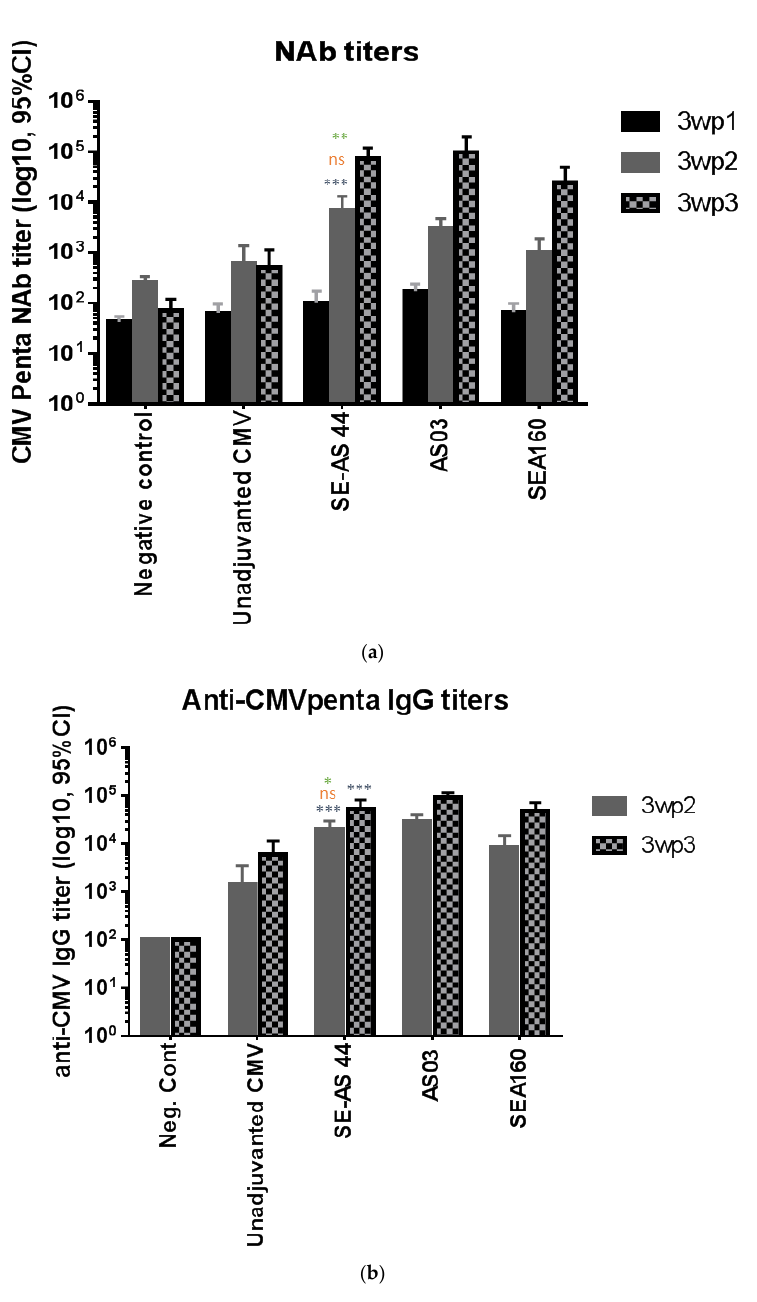
Figure 3. ( a ) Neutralizing antibody titers in serum obtained three weeks post-1st, 2nd and 3rd immunization against the CMV TB40 strain of virus. Each bar represents geometric mean titers (GMT) with 95% confidence interval (CI) from n = 10 animals per group. Statistical analysis was performed using one-way ANOVA followed by Tukey’s test to compare all groups with each other followed by Dunnett’s multiple comparisons test to compare each group with SE-AS44. Significant differences are marked on the graph only for 3wp2 titers. Comparison with CMV alone is shown in blue, with AS03 is shown in red, and with SEA160 is shown in green; ns = not significant, ** = p < 0.005, *** = p < 0.0005. ( b ) Anti-CMV Penta IgG antibody titers in serum obtained three weeks post-1st, 2nd and 3rd immunization against the CMV TB40 strain of virus. Each bar represents geometric mean titers (GMT) with 95% confidence interval (CI) from n = 10 animals per group. Statistical analysis was performed using one-way ANOVA followed by Dunnett’s multiple comparisons test to compare differences between each group with SE-AS44. Significant differences are marked on the graph. Comparison with CMV alone is shown in blue, with AS03 is shown in red and with SEA160 is shown in green; ns = not significant, * = p < 0.05, *** = p <